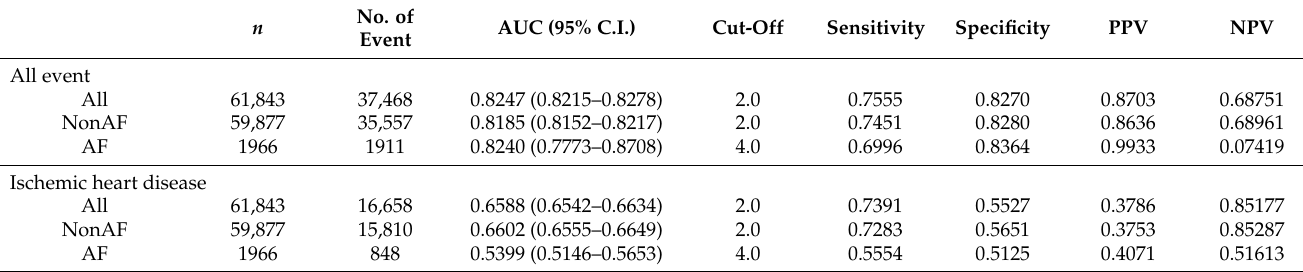
Table 3. Diagnostic performance of CHA2DS2-VASc score in predicting of